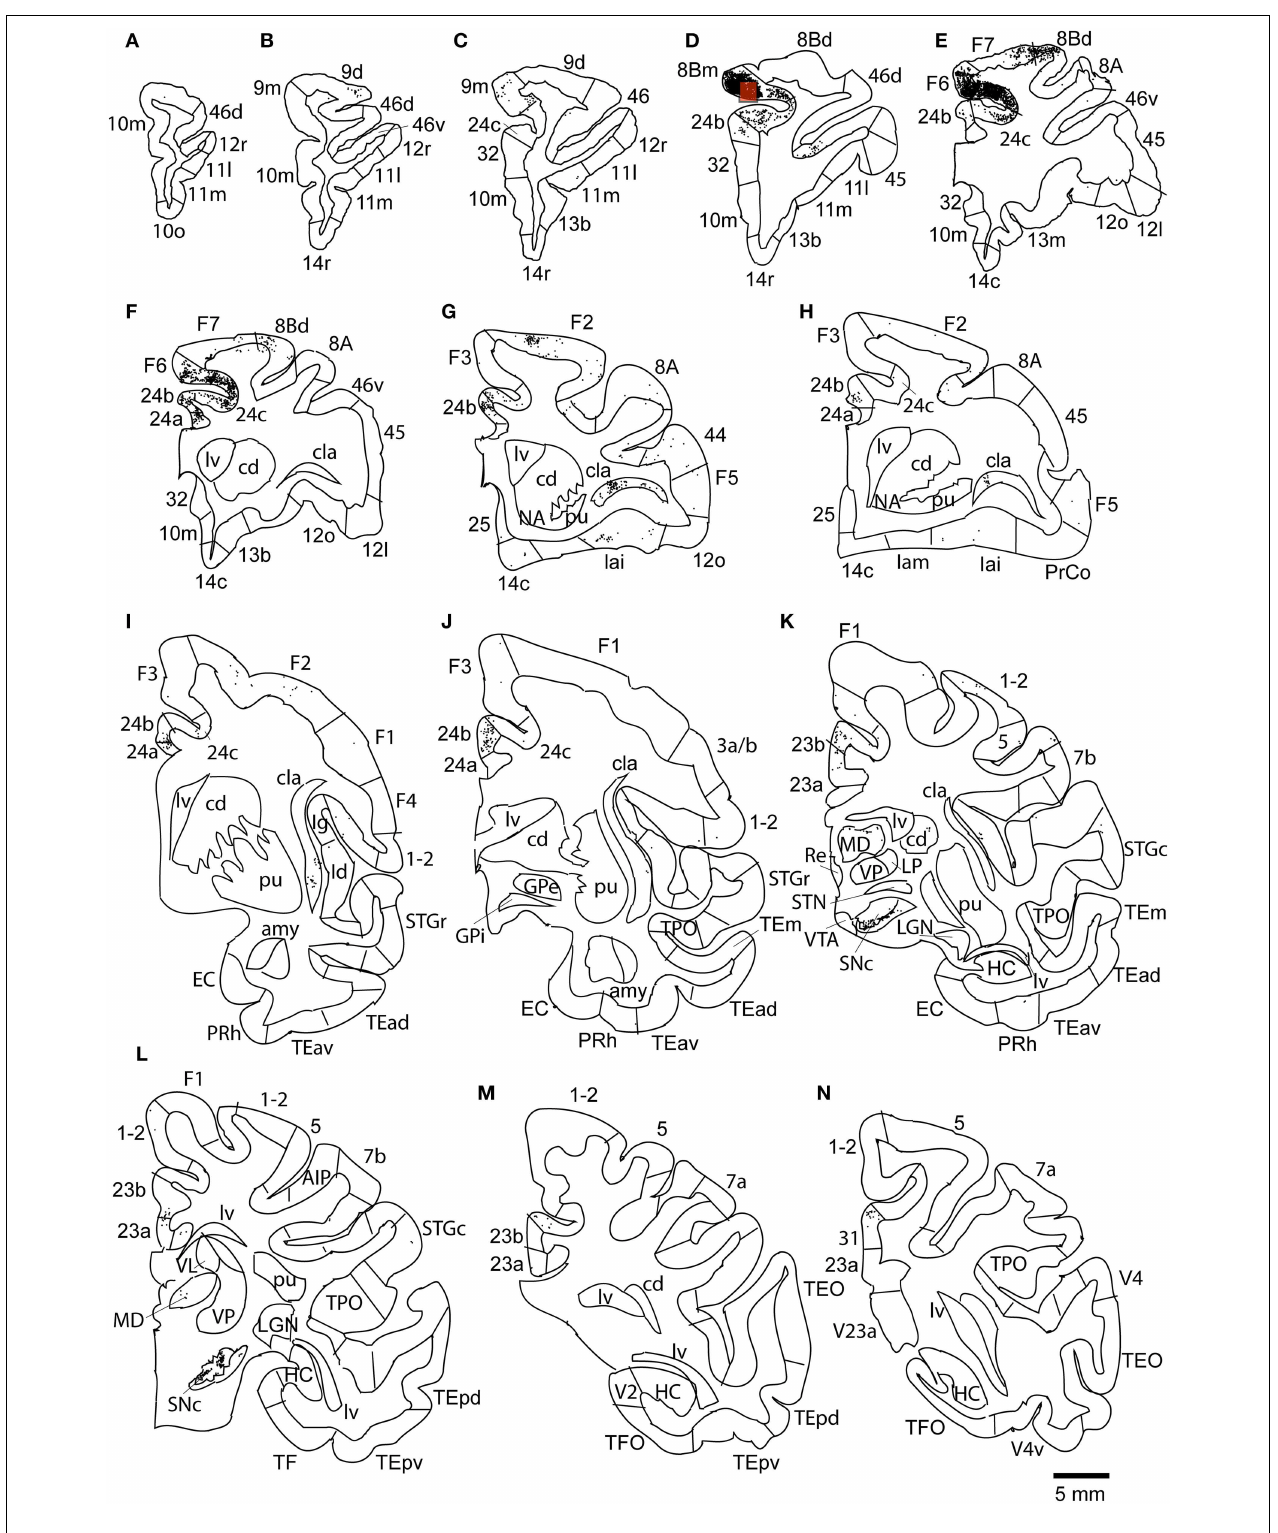
FIGURE 8 | Distribution of retrogradely labeled neurons on coronal sections in Case 2L (A–N). The abbreviations used to mark cortical areas are shown in the Abbreviations in the main